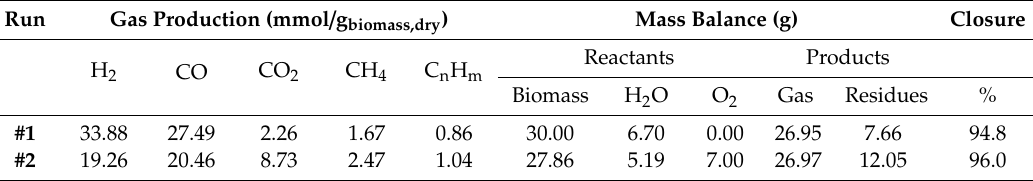
Table 3. Gas yield and mass balance closure for beechwood gasification.